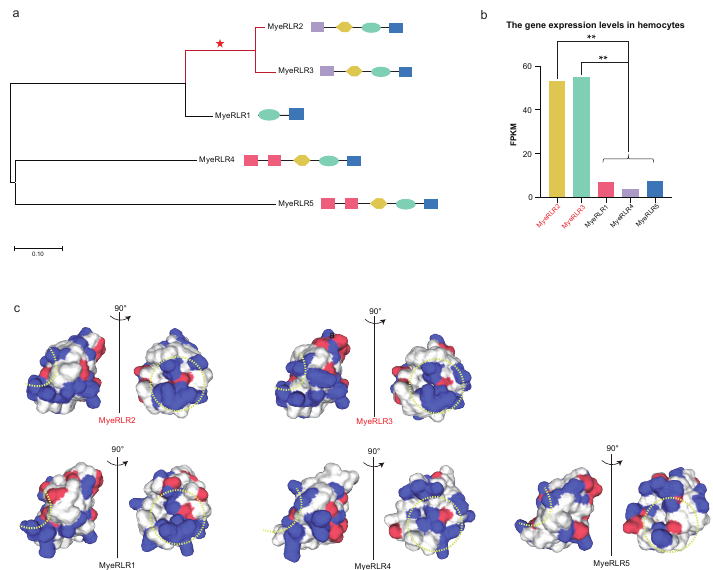
Figure 8. Positive selection analysis of representative RLR genes. ( a ) Evolutionary relationships of MyeRLRs . The branches with dN / dS ( ω ) values > 1.0 are marked with red lines. ( b ) The expression level of five MyeRLRs in hemocytes. One-way ANOVA showed that the expression levels of MyeRLR2 and MyeRLR3 were significantly ( p -value < 0.01, marked with **) more upregulated than those of other MyeRLRs . ( c ) Electrostatics of the RNA-binding surfaces of the MyeRLR RIG-I_C-RDs. The determination of RNA-binding sites refers to previous studies [49]. Positively charged surfaces are colored blue, and negatively charged surfaces are red. Dotted yellow line indicates RNA-binding